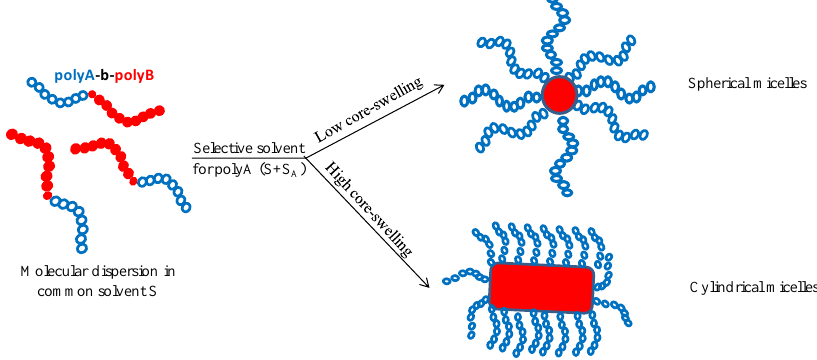
Figure 4. Schematization of the polyA-polyB diblock copolymer self-assembly process in solvents mixture.